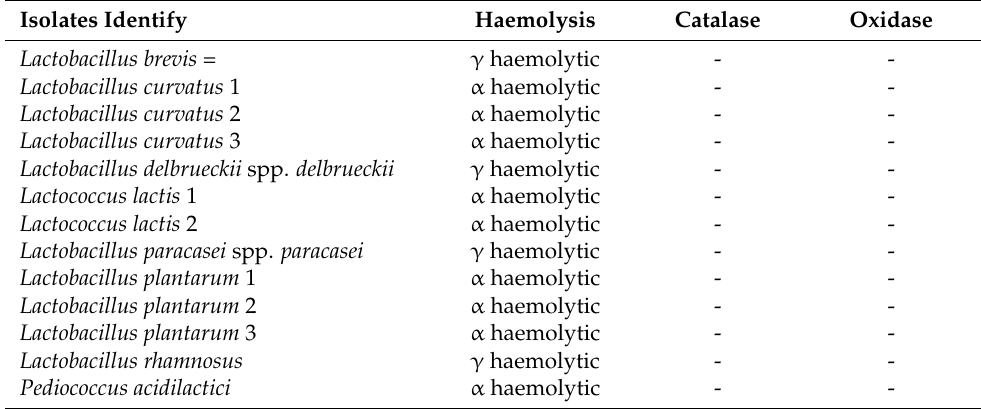
Table 3. Selected LAB strains with α and γ haemolytic capacity, and negative catalase/oxidase tests. Isolates Identify